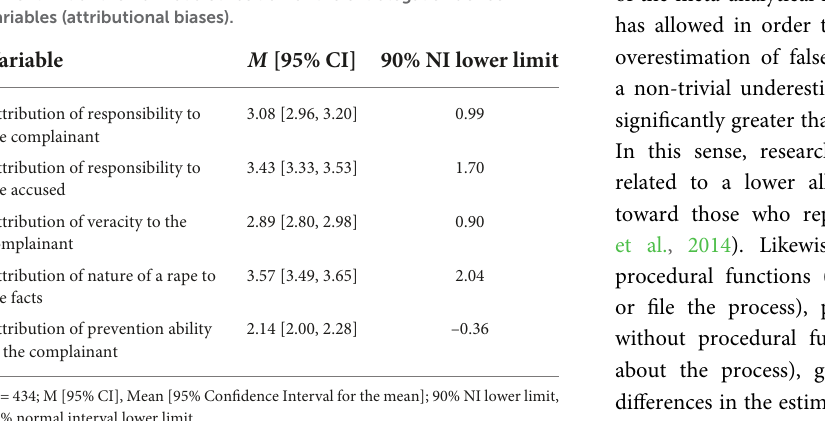
TABLE 5 Confidence interval for the observed mean and populational lower limit of the normal distribution of the extralegal evidence variables (attributional